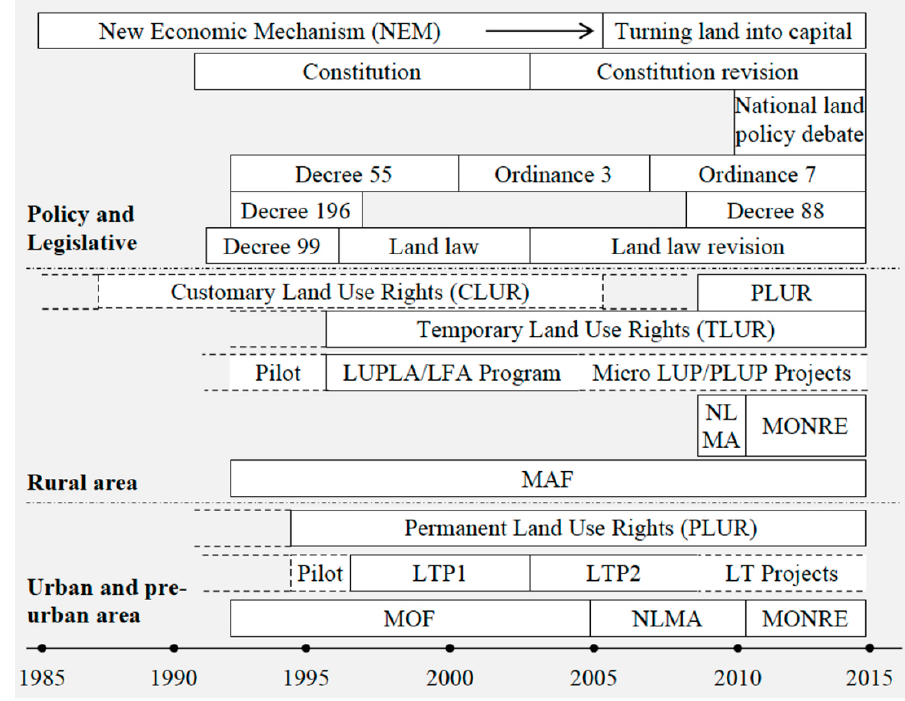
Figure 2. Key events since 1985 relating to the granting of land use rights in Laos. Source: Based on information from [9,10,16,18,22].